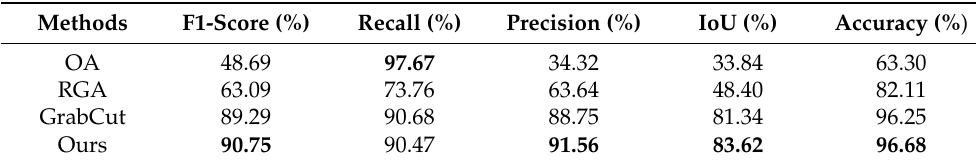
Table 3. Comparison with the traditional methods on the test